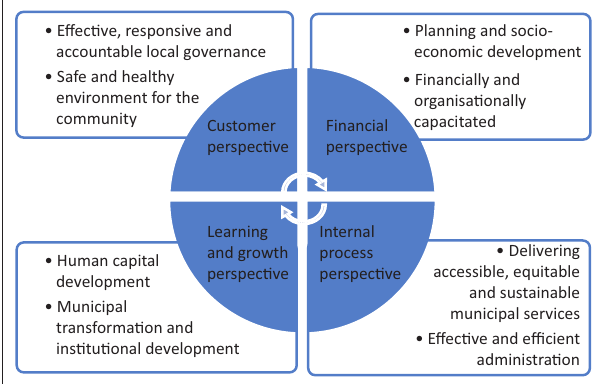
FIGURE 4: The four perspectives of the Joe Gqabi District Municipality scorecard